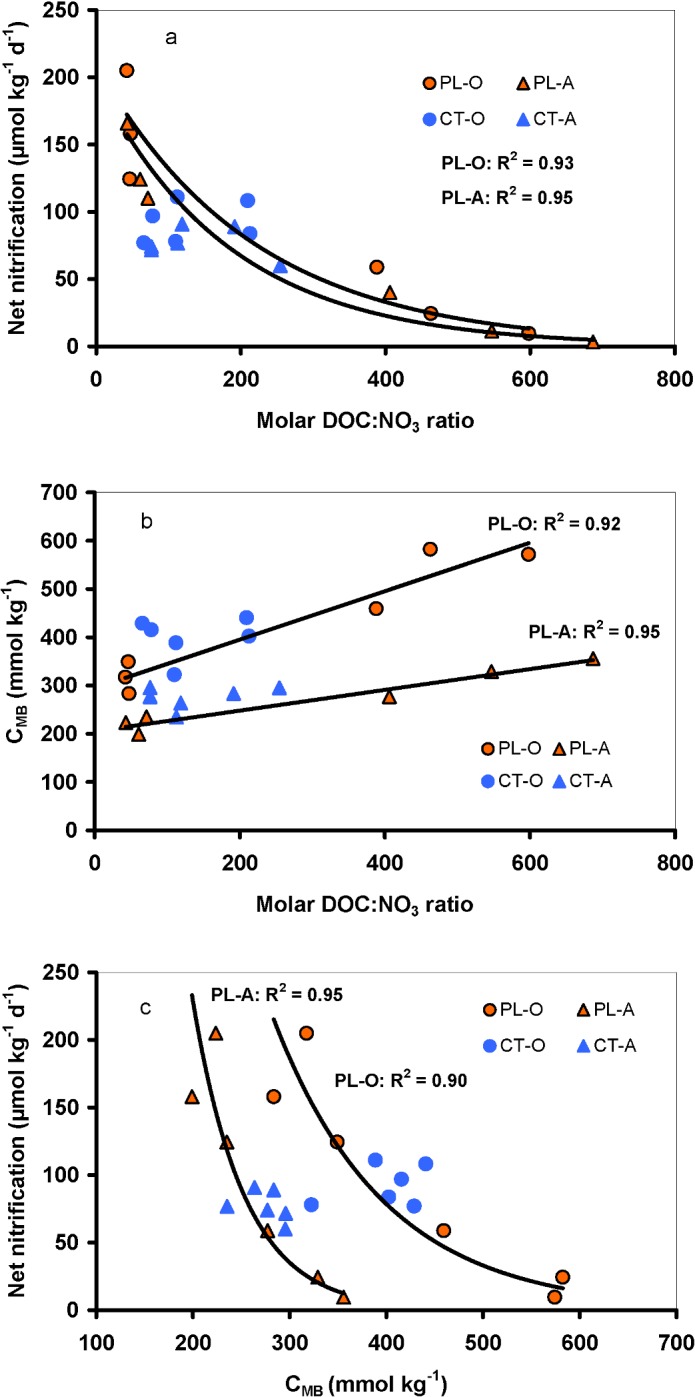
Relationships between annual average (n = 8–9 for each year) molar DOC:NO3 ratio in water extracts and (a) annual average net nitrification, (b) C in microbial biomass (CMB), and (c) between CMB and net nitrification in the O and A soil horizons at the Plešné (PL) and Čertovo (CT) plots.Lines indicate statistically significant (p<0.01) correlations of respective parameters in soils from the PL plot.